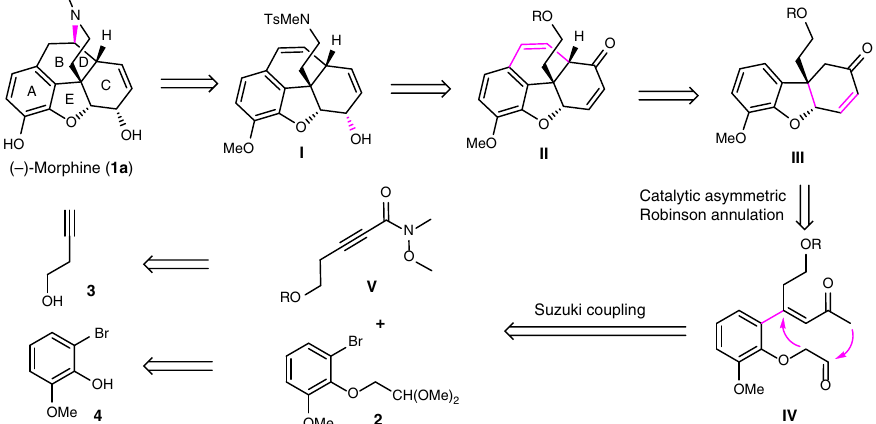
Fig. 2 Our synthetic strategy towards ( ‒ )-morphine. This proposed protocol is featuring a catalytic asymmetric Robinson annulation to construct the AEC ring system of ( ‒ )-morphine with high ef fi ciency